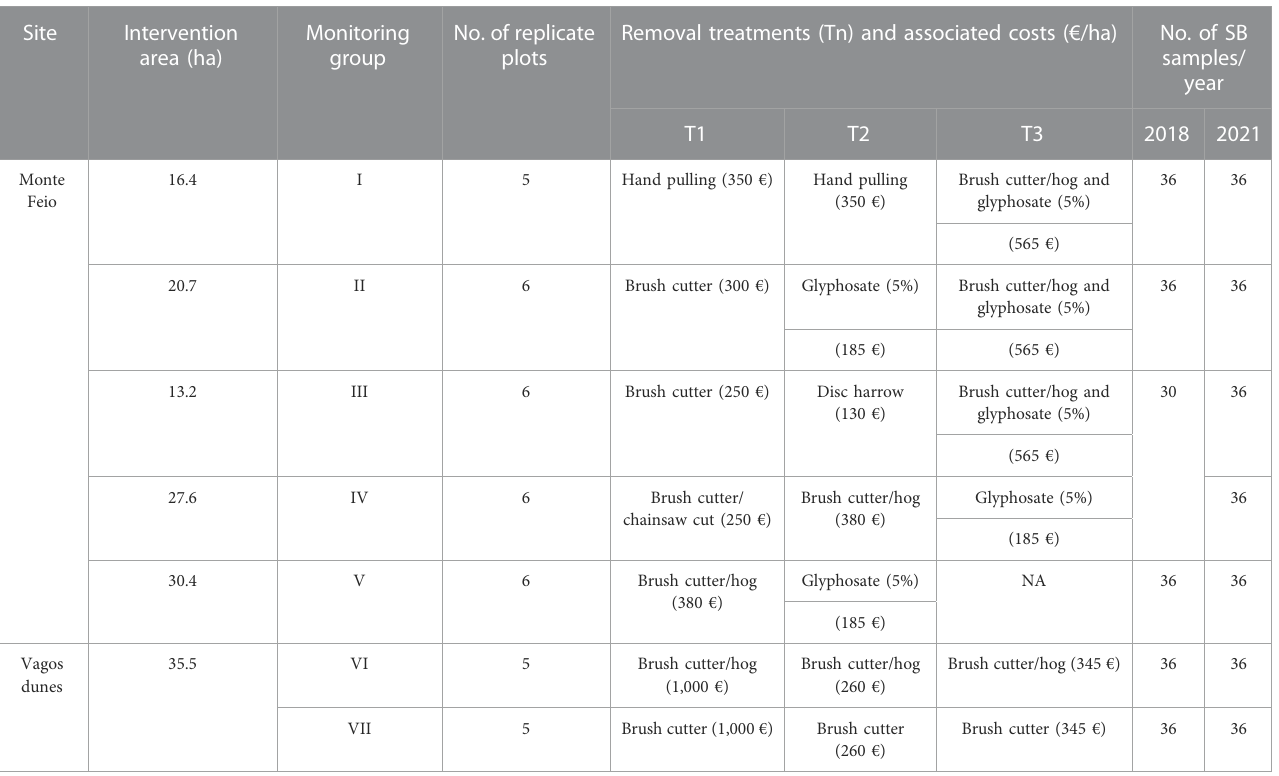
TABLE 1 Removal methods and associated monitoring groups in each site. Tn refers to the removal treatment applied: T1 — initial control, T2 — fi rst follow-up control, and T3 — second follow-up control. Information on the intervention costs ( € /ha) paid to contractors is provided within brackets. Detailed information on each treatment is provided in Supplementary Table S1. SB means seed